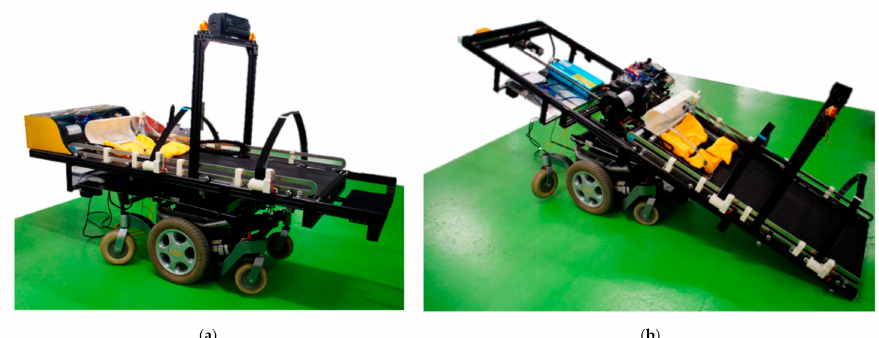
Figure 10. The fully assembled ResQbot 2.0. ( a ) The compact configuration is used for general navigation and casualty transportation. ( b ) ResQbot 2.0 in the loading configuration, allowing the robot to adjust its configuration to the optimal loading angle to perform the casualty extraction procedure safely.